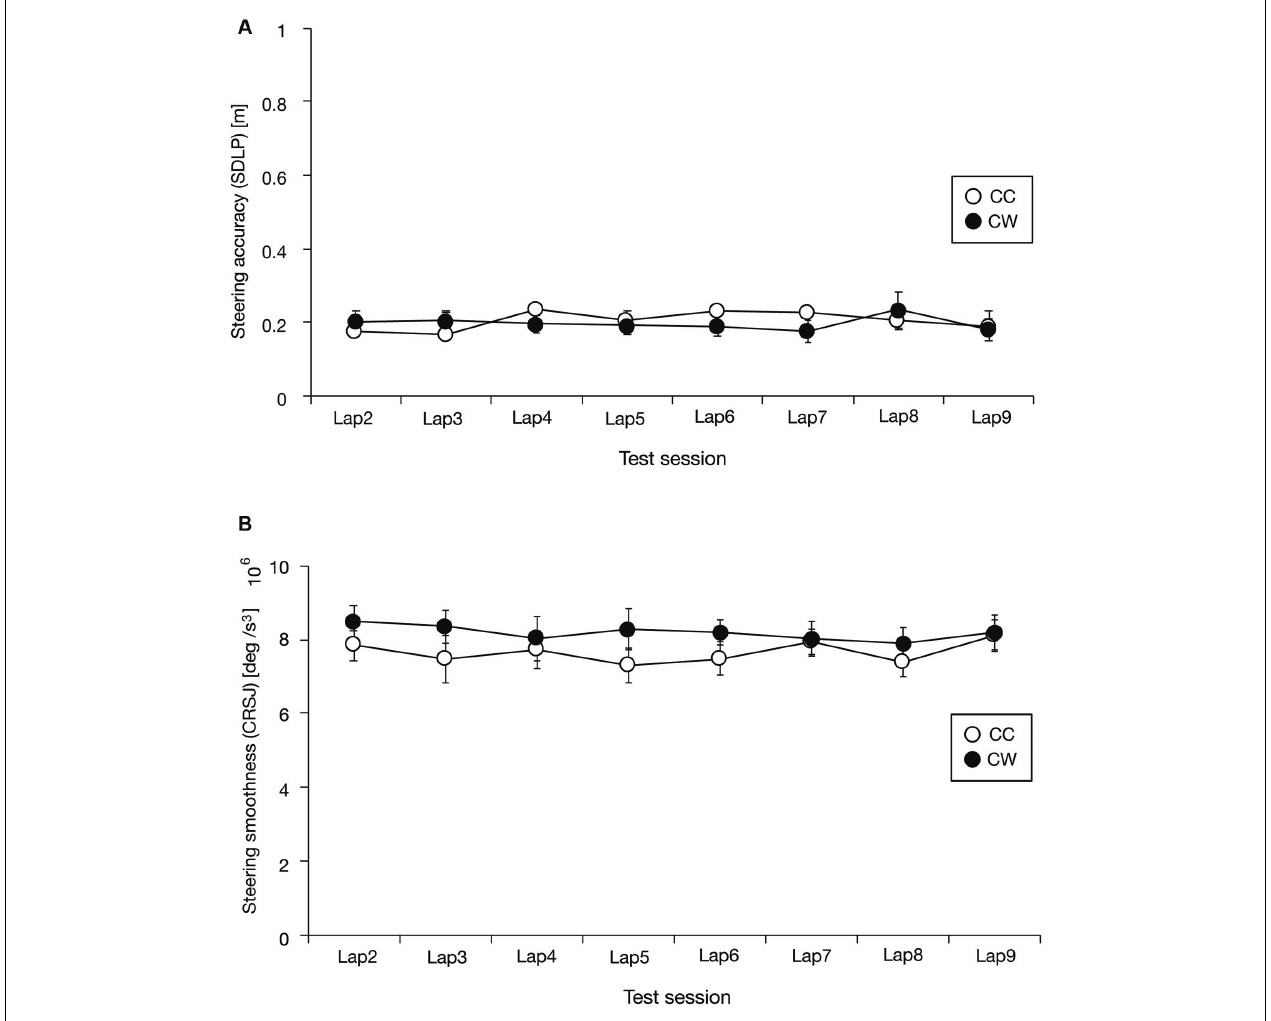
FIGURE 5 | Driving performance as a function of a lap in the test session [steering accuracy: (A) , steering smoothness: (B) ]. Steering accuracy seems to be comparable in both the counter-clockwise circling condition (CC) and the clockwise circling condition (CW) whereas steering smoothness seems to be worse in the CW condition than in the CC condition. SDLP and CRSJ denote the standard deviation of lateral position and the cumulative root squared jerk, respectively. Error bars represent 95% confidence